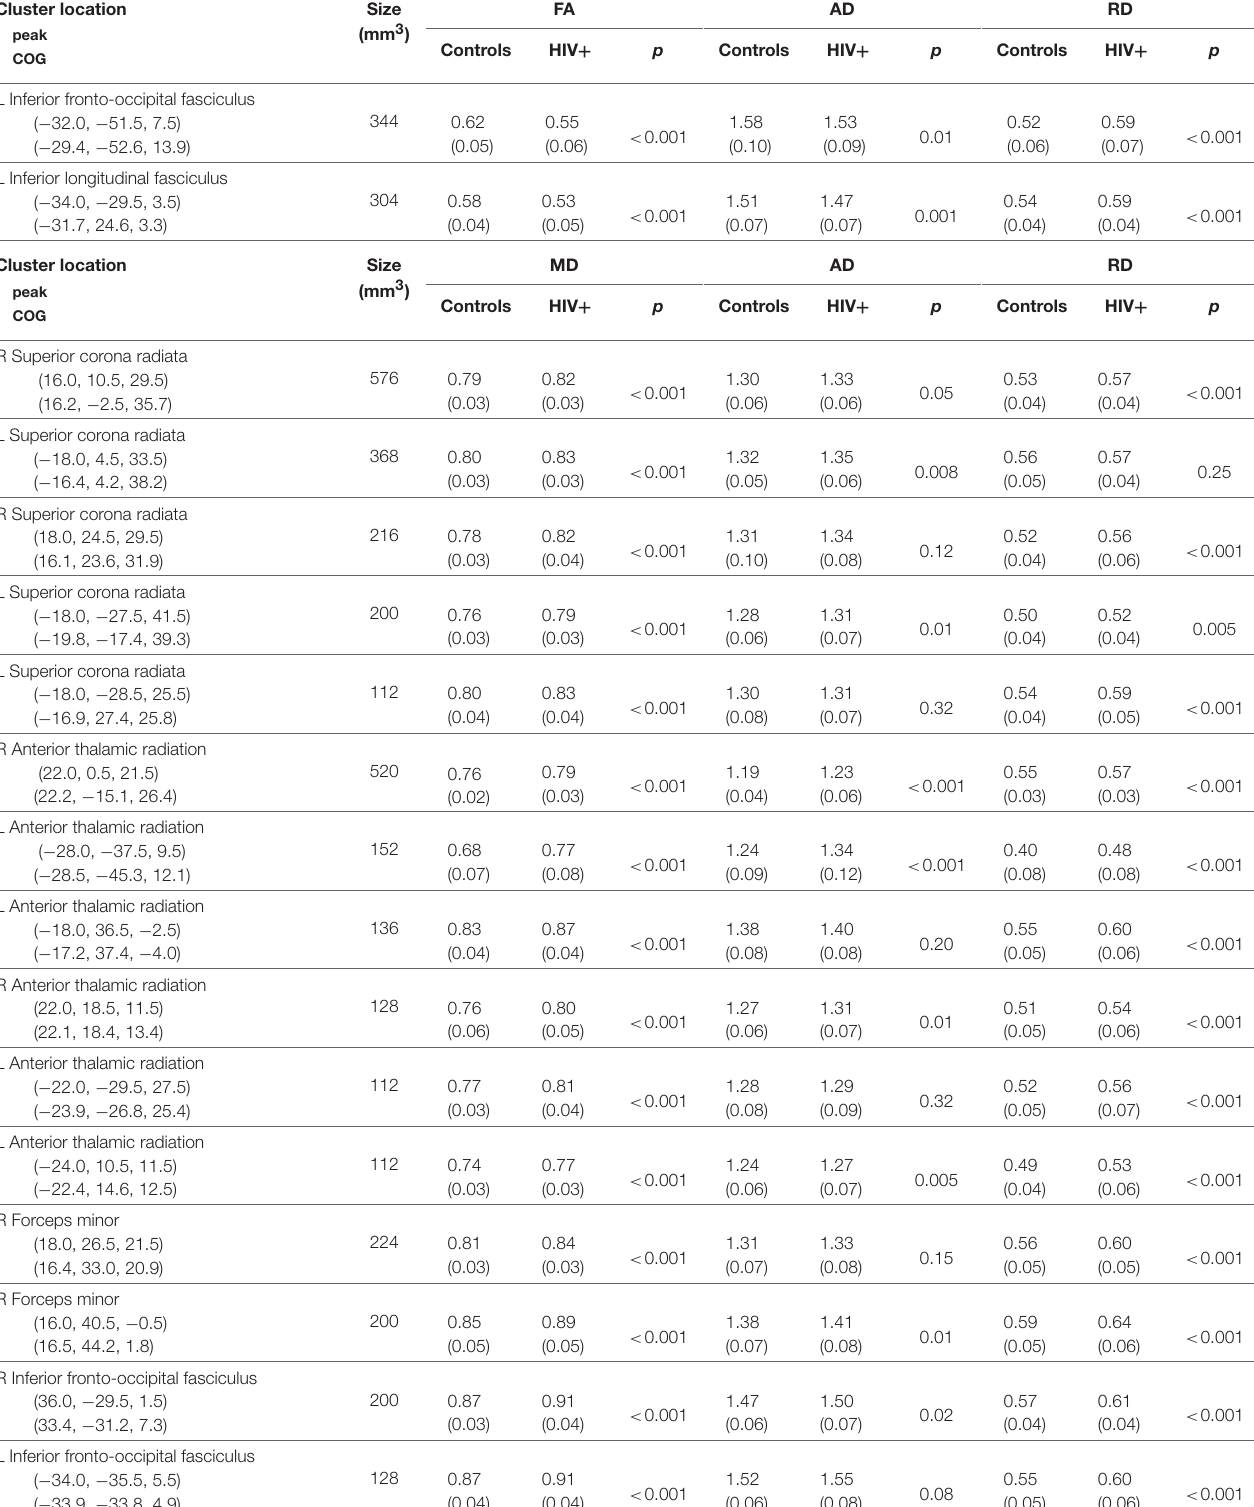
TABLE 2 | Peak (top) and center of gravity (COG) (bottom) MNI coordinates of clusters showing significant differences in FA or MD between Controls and HIV + children. Cluster location Size FA AD RD peak (mm 3 Controls HIV + p Controls HIV + p Controls HIV + p